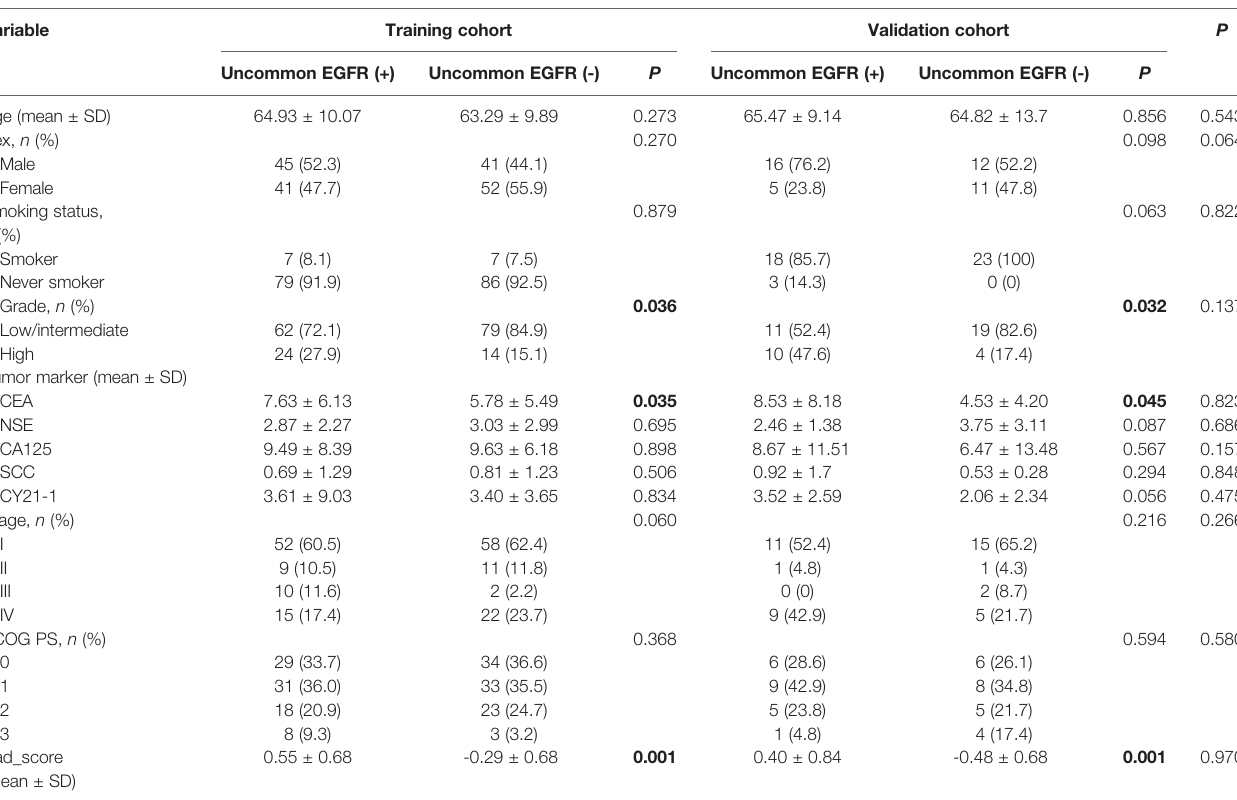
TABLE 1 | Clinicopathological data of patients in the training and validation cohorts.